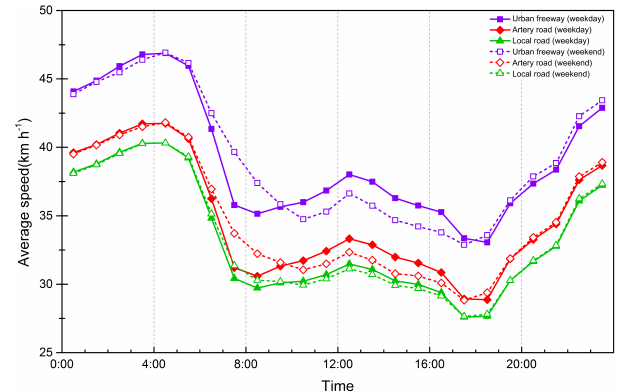
Figure 4. Hourly traffic volume on different road types in